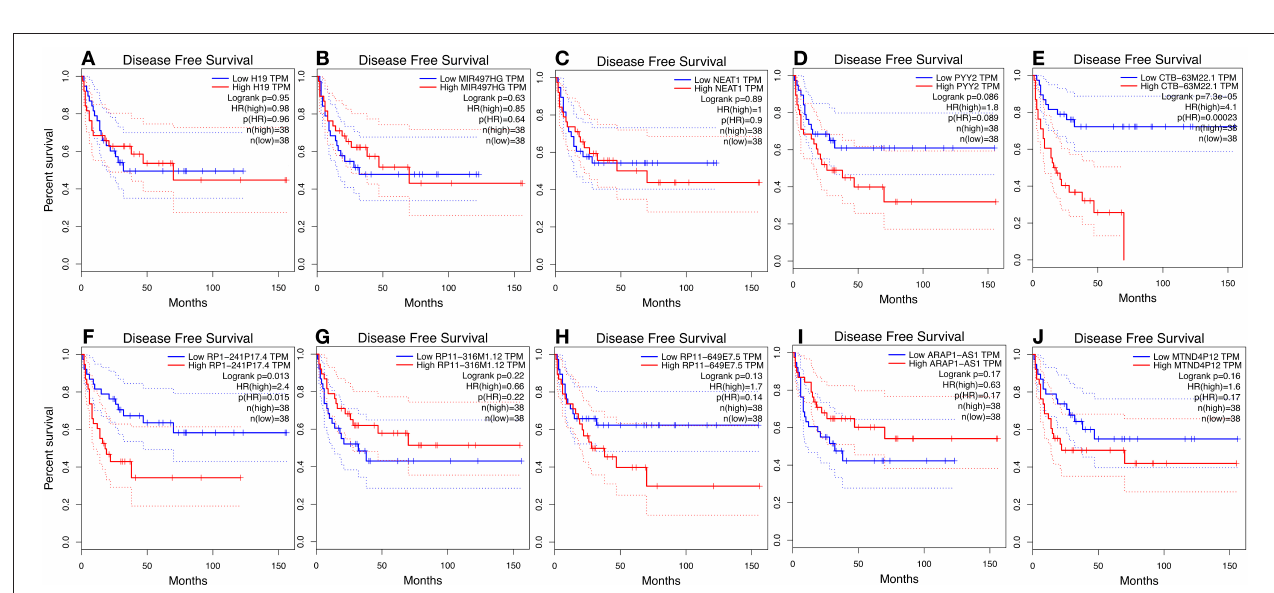
FIGURE 6 | (A–J) : Disease free survival plot of 10 pivotal ceRNAs using 77 ACC patient data from TCGA database.